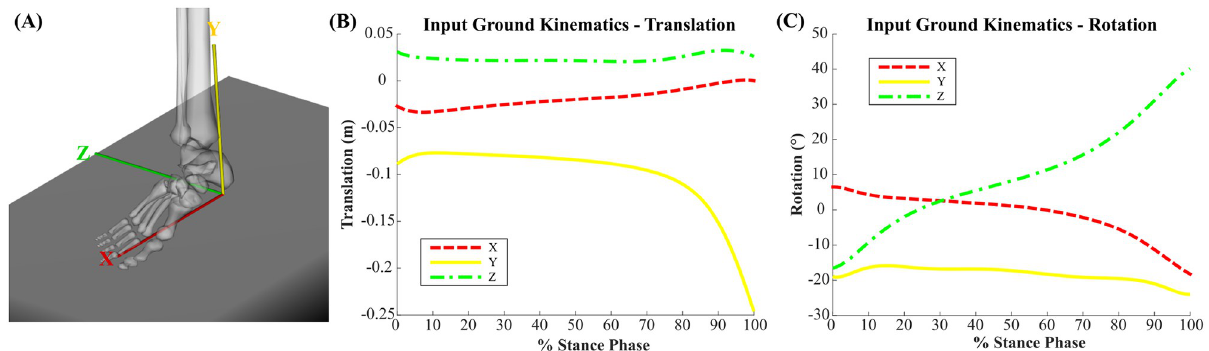
Fig 7. Ground plane kinematics. Kinematic trajectory of the ground plane used as an input to gait simulation. (A) shows the local coordinate axes of the ground plane with respect to the orientation of a foot model. The input kinematic trajectory is split into (B) translational and (C) rotational components.